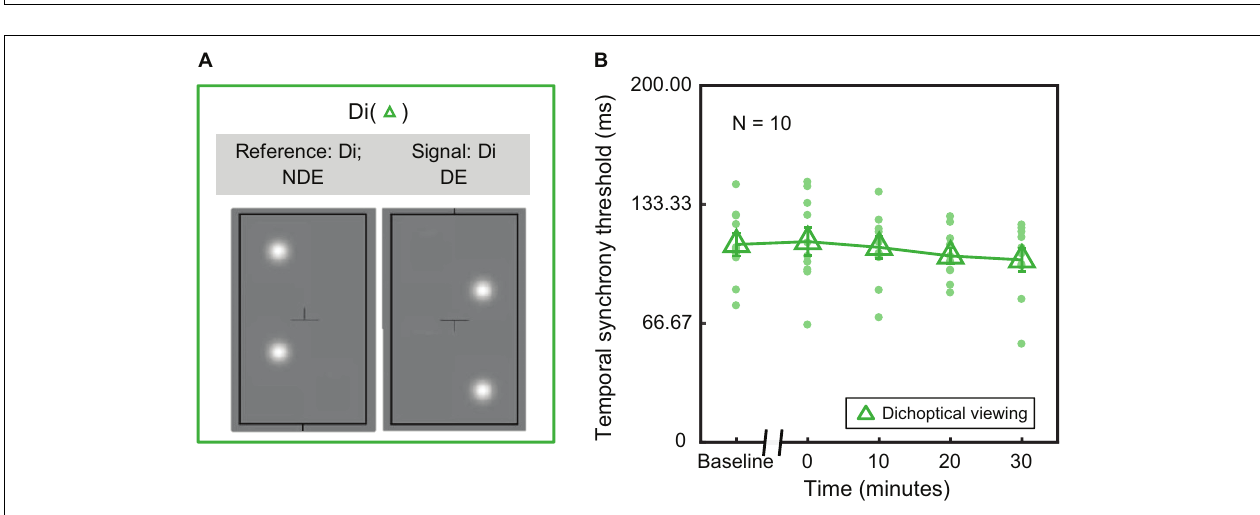
FIGURE 1 | An illustration of the experimental procedure. We deprived one eye for 2.5 h, and assessed the temporal synchrony thresholds at baseline, and 0, 10, 20, 30 min after the finish of the 2.5-h of deprivation.